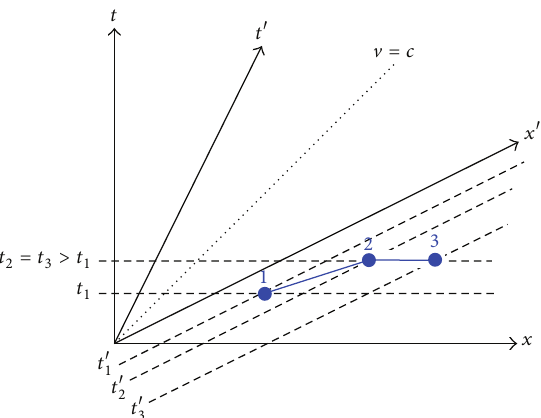
Figure 3: The world line 1 󳨃→ 2 󳨃→ 3 describes the tachyonic neutrino decay into a zero-energy, infinitely fast neutrino. Complete reversal of the time ordering of the decay process takes place in the primed frame; the observer interprets the process as the decay of an incoming antineutrino along the trajectory 3 󳨃→ 2 󳨃→ 1